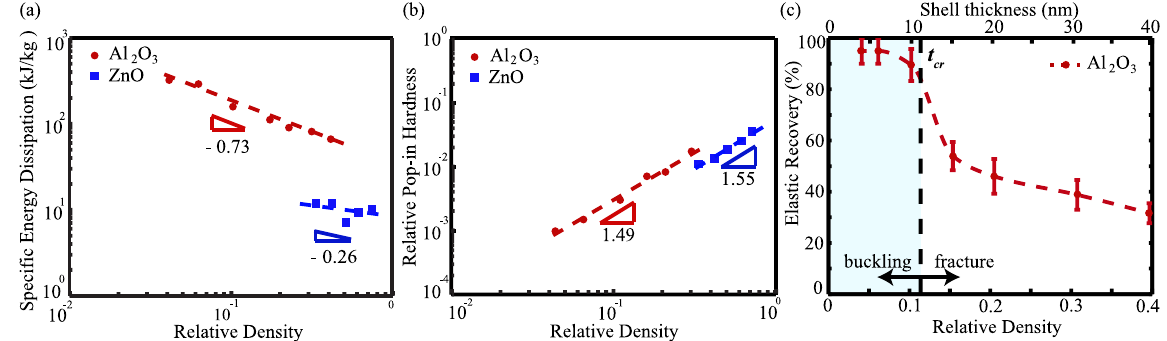
Figure 4. Mechanical Properties of nanolattice film. ( a ) Specific energy dissipation for Al 2 O 3 and ZnO nanolattice plotted against relative density. The Al 2 O 3 nanolattice shows more favorable power law scaling. ( b ) Pop-in hardness versus relative density. The nanolattice shows similar hardness scaling for both Al 2 O 3 and ZnO. ( c ) Elastic recovery of Al 2 O 3 nanolattice film plotted as a function of relative density and nanolattice shell thickness. Error bars represent standard deviation in elastic